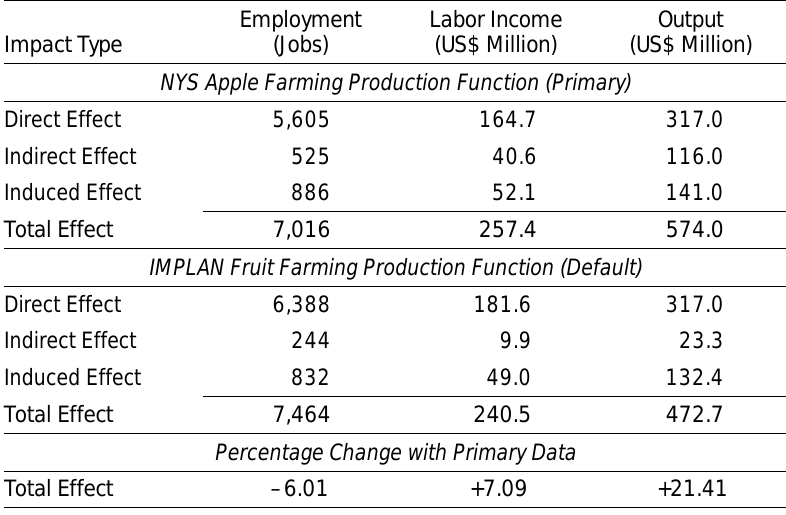
Table 3. Economic Contributions for Apple Farming with Author- Constructed Production Function and IMPLAN’s Fruit Farming Production